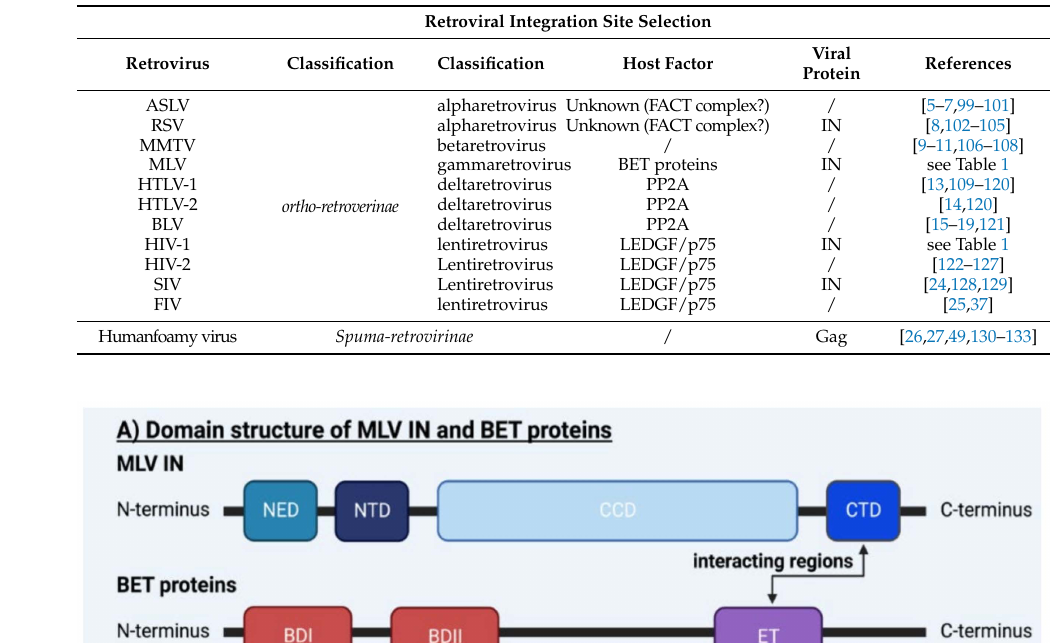
Table 2. Determinants of retroviral integration site selection. Avian sarcoma-leukosis virus (ASLV); bromodomain and extra terminal motif (BET); bovine leukemia virus (BLV); facilitates chromatin transcription complex (FACT complex); feline immunodeficiency virus (FIV); group–specific antigen (Gag); human immunodeficiency virus type 1 (HIV-1); human immunodeficiency virus type 2 (HIV- 2); human T lymphotropic virus type 1 (HTLV-1); human T lymphotropic virus type 2 (HTLV-2); integrase (IN); lens epithelium–derived growth factor (LEDGF/p75); mouse mammary tumor virus (MMTV); murine leukemia virus (MLV); protein phosphatase 2A (PP2A); Rous sarcoma virus (RSV); simian immunodeficiency virus (SIV). (Table created with Biorender.com on 17 December 2022).